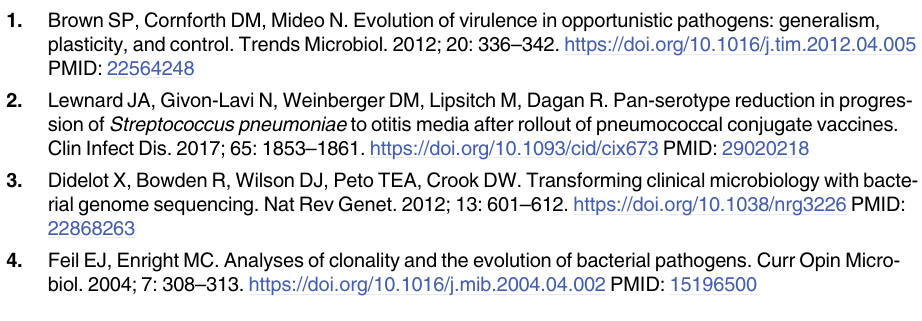
S2 Dataset. Invasiveness estimates for serotypes in adults. The median estimates, and lower and upper bounds of the 95% credibility interval, are listed for each serotype. S3 Dataset. Invasiveness estimates for serotypes and strains, calculated from genotyped isolates from child disease and carriage. Each row corresponds to a serotype-strain combina- tion. Both the invasiveness associated with the serotype, and the invasiveness coefficient asso- ciated with the strain, are listed, along with the corresponding lower and upper bounds of their 95% credibility